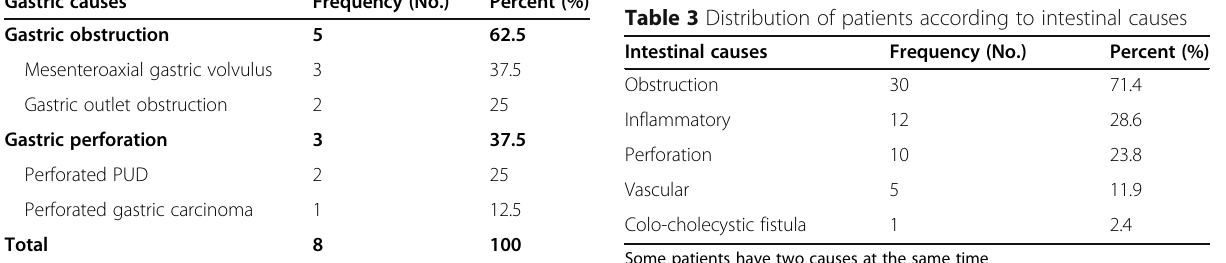
Table 3 Distribution of patients according to intestinal causes Intestinal causes Frequency